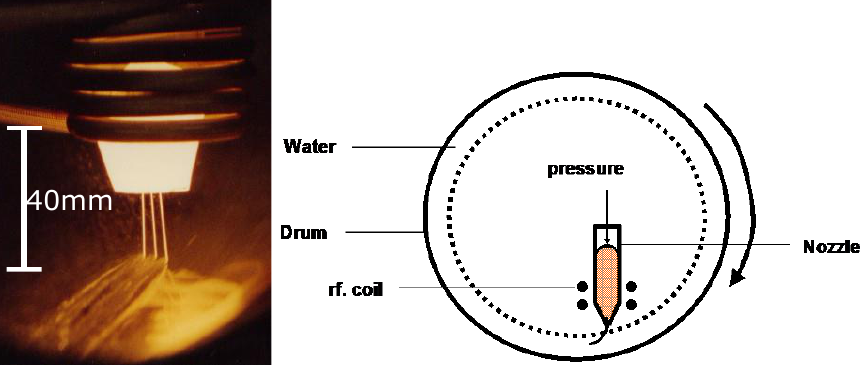
Figure 2. ( a ) Unbroken melt jet streams maintained for over 20 mm under streaming conditions. ( b ) Schematic diagram of the wire